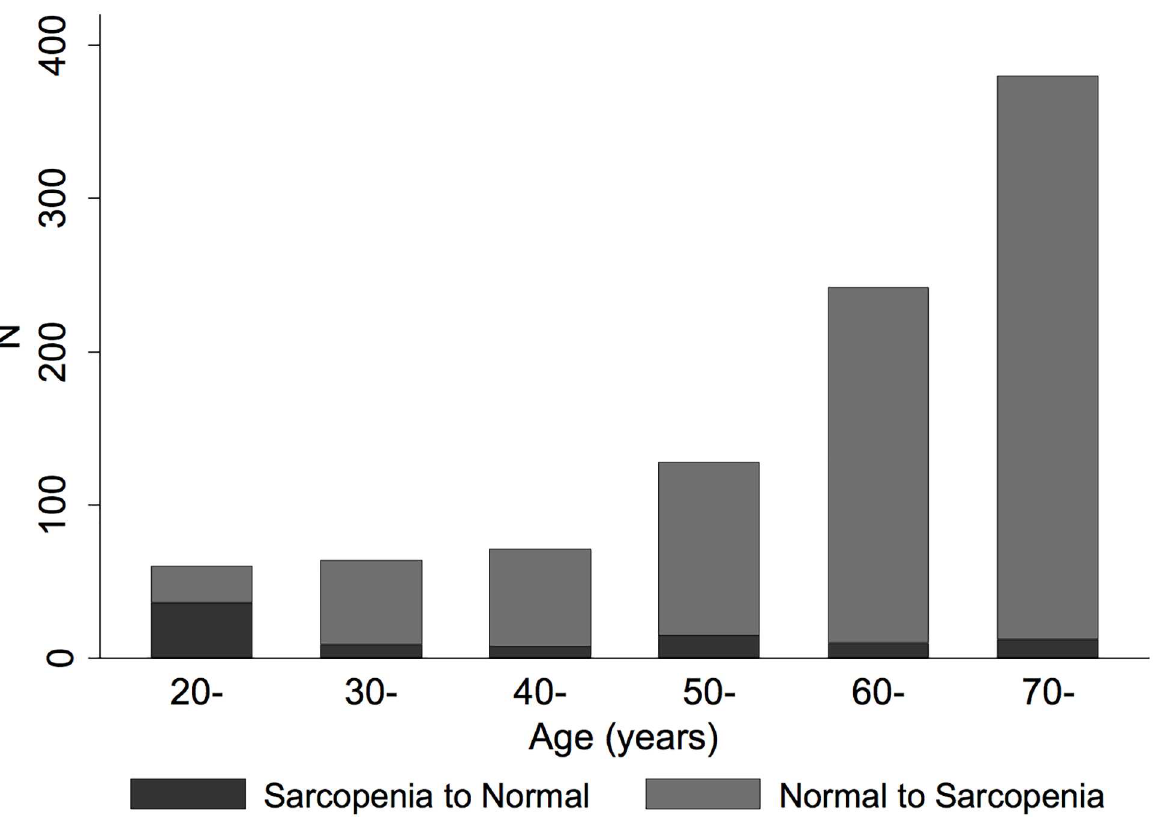
Fig 3. Younger individuals are likely to be reclassified as normal based on ALMI FMI , while elderly individuals are likely to be reclassified as having low lean mass. Illustration of subjects that were reclassified with the fat-adjusted definitionof sarcopenia across the age range demonstrating greater re-classification to sarcopenia among older